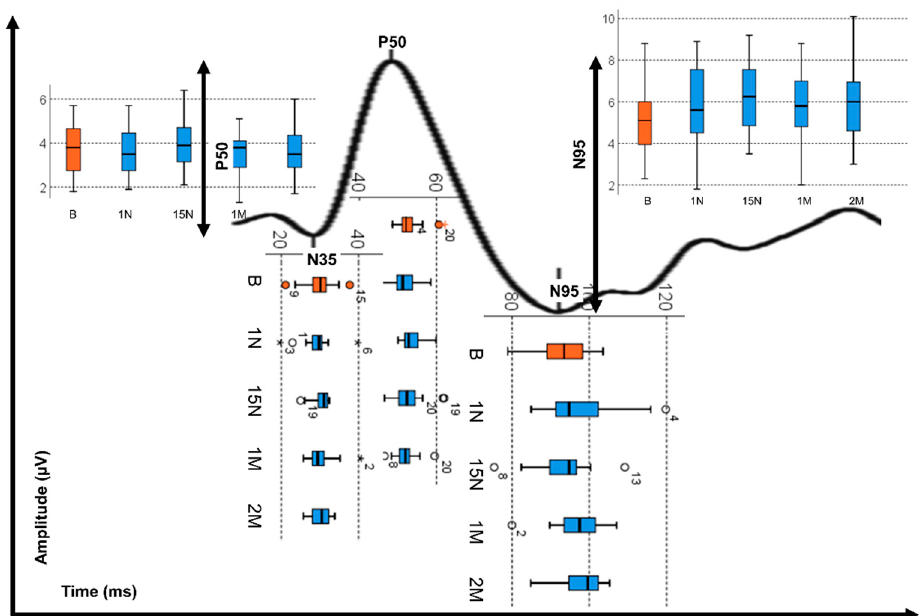
Baseline and 60 nights) and 15N − 60N (visits 15 nights and 60 nights).